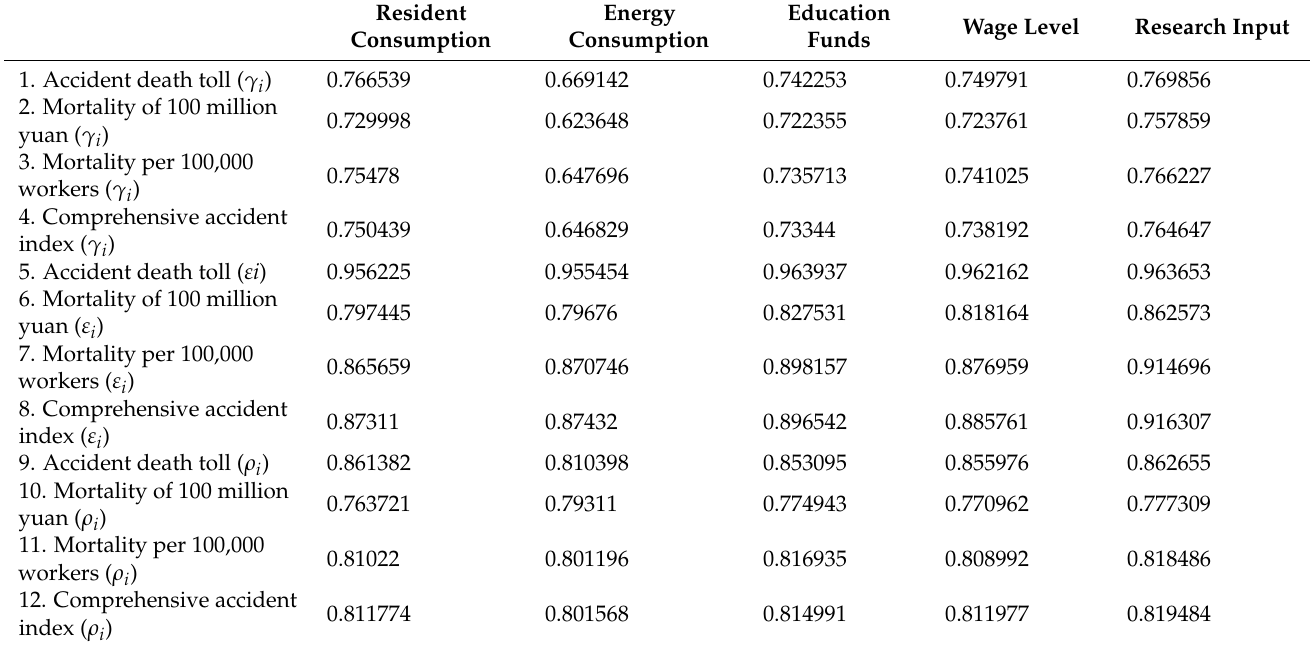
Table 2. Correlation coefficient between accident indicators and economic